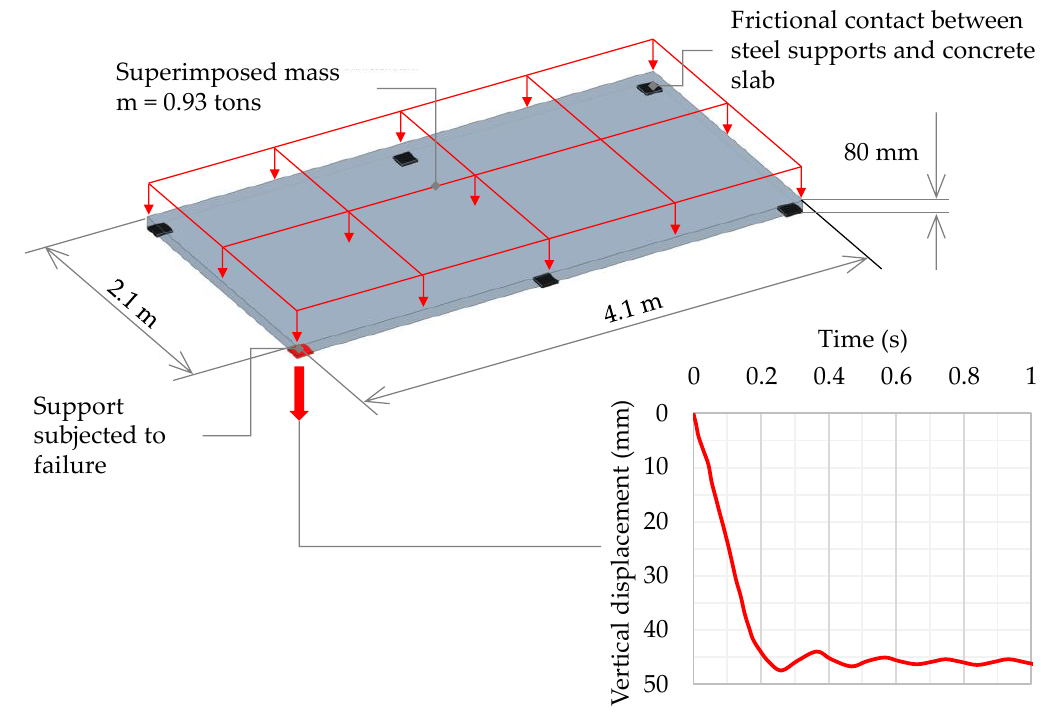
Figure 1. Details of the reinforced concrete flat slab experiment.